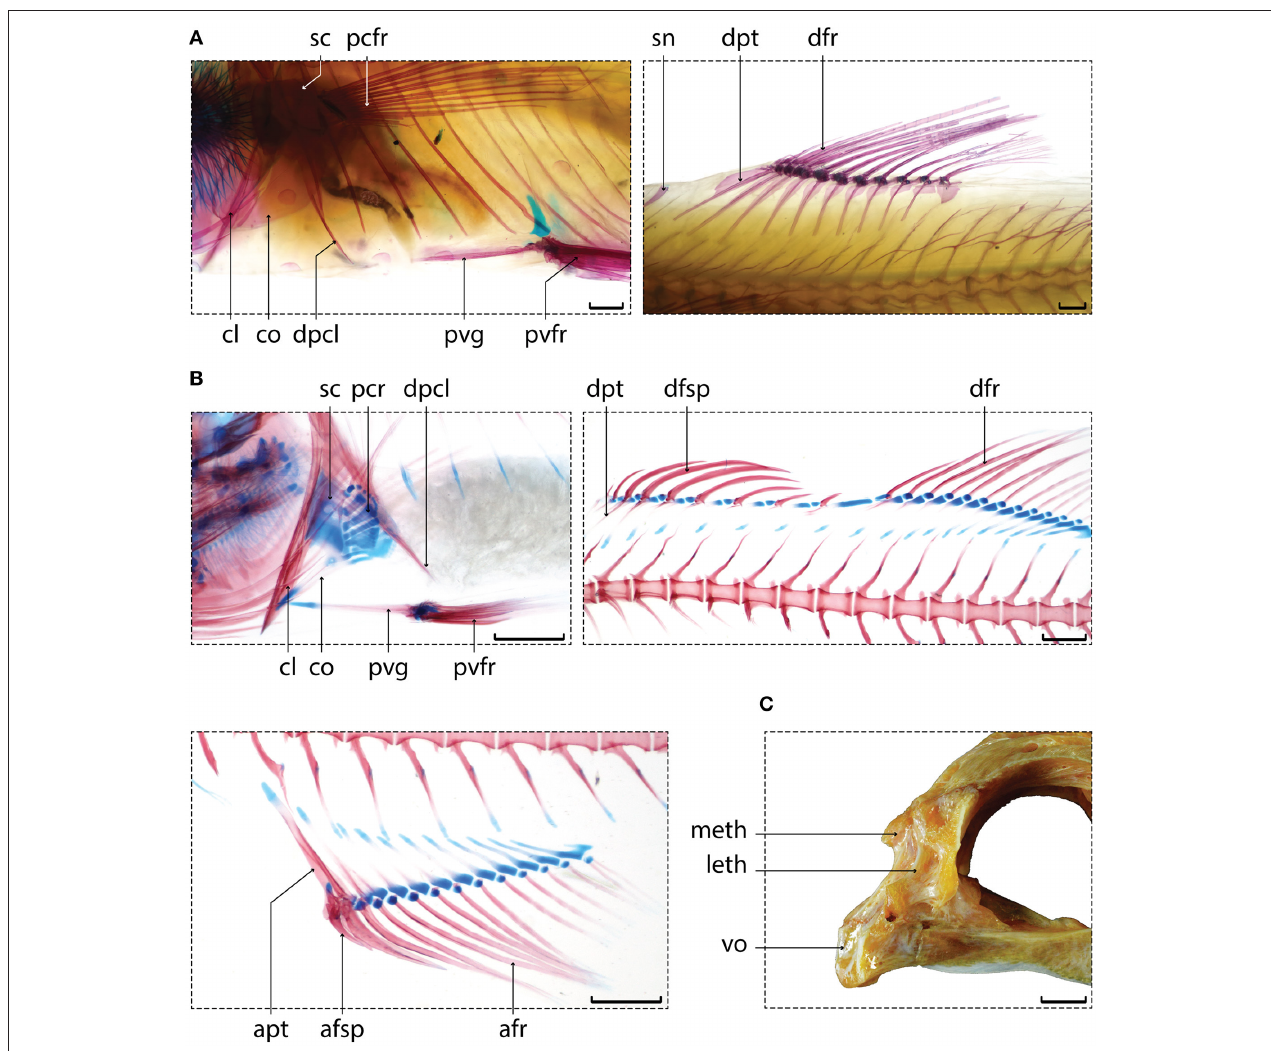
FIGURE 6 | Examples of acanthomorph synapomorphies. (A) Relative positions of the pelvic and pectoral girdle (left), and dorsal fin (right) of a non-acanthomorph, Myctophum nidulum , MNHN.IC.1993.2333. (B) Relative positions of the pelvic and pectoral girdle (left), dorsal fins (right), and anal fin (below) of an acanthomorph, Dicentrarchus labrax , MNHN uncataloged. (C) Ethmoid region of an acanthomorph, Sparus aurata , MNHN uncataloged. Abbreviations: afr, anal-fin soft rays; afsp, anal-fin spines; apt, anal pterygiophore; cl, cleithrum; co, coracoid; dfr, dorsal-fin soft rays; dfsp, dorsal-fin spines; dpcl, distal postcleithrum; dpt, dorsal pterygiophores; leth, lateral ethmoid; meth, mesethmoid; pcfr, pectoral-fin rays; pcr, pectoral radials; pvg, pelvic girdle; pvfr, pelvic-fin rays; sc, scapula; sn, supraneurals; vo, vomer. Scale bar equals 1 mm (A,B) , 10 mm (C) . C&S preparations N. K. Schnell. Photos D. Davesne and N. K.